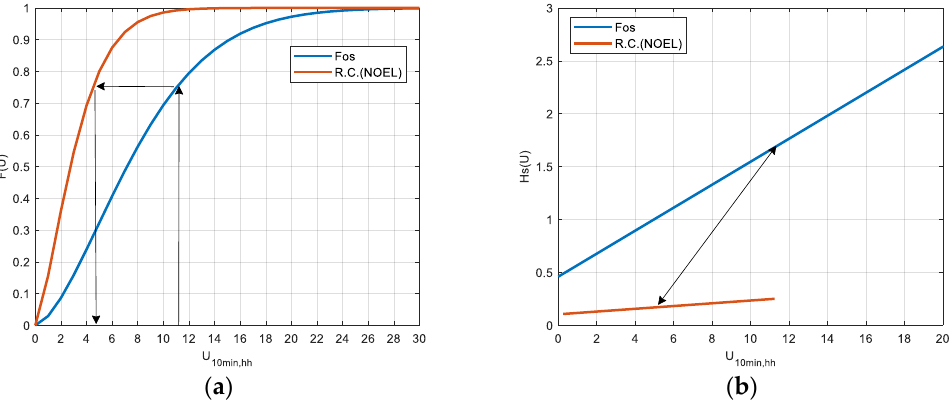
Figure 2. Comparison between the full-scale deployment site (Fos) and test site at Natural Ocean Engineering Laboratory (NOEL) (R. C.) in terms of the wind speed cumulative distribution ( a ). Significant wave height Hs as a function of the wind speed ( b ). U 10min,hh is the 10-min mean hub-height wind speed. Table 4. Actual gross properties of the DTU 10 MW, wind tunnel model (WTM) and Blue Growth Farm (BGF) model.